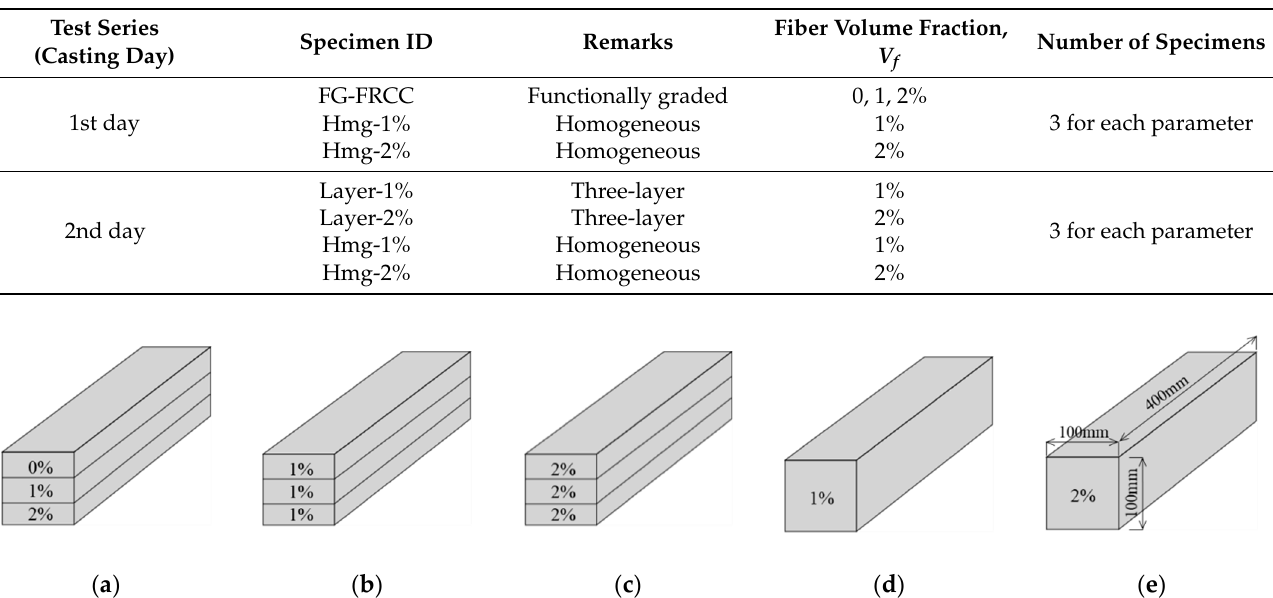
Table 3. List of specimens.